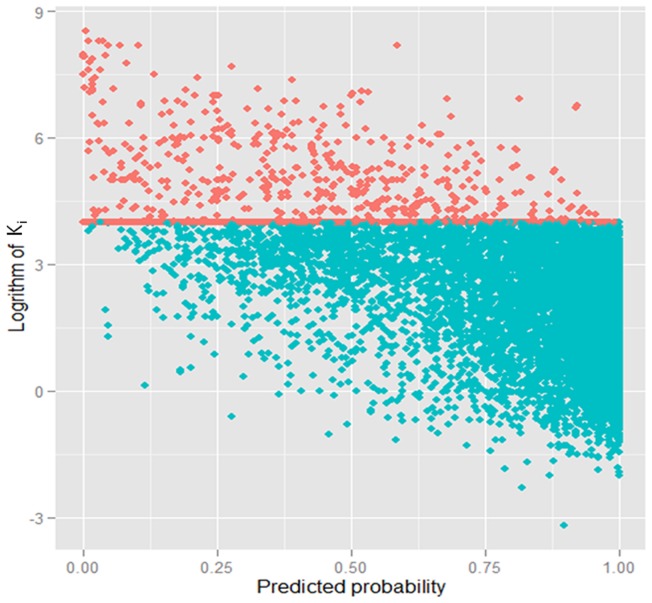
The plot of Ki versus prediction probability on 5-fold cross validation.non-interaction: red and interaction: green. Linear relationship between Ki and prediction probability could be observed with correlation coefficient of 0.65.